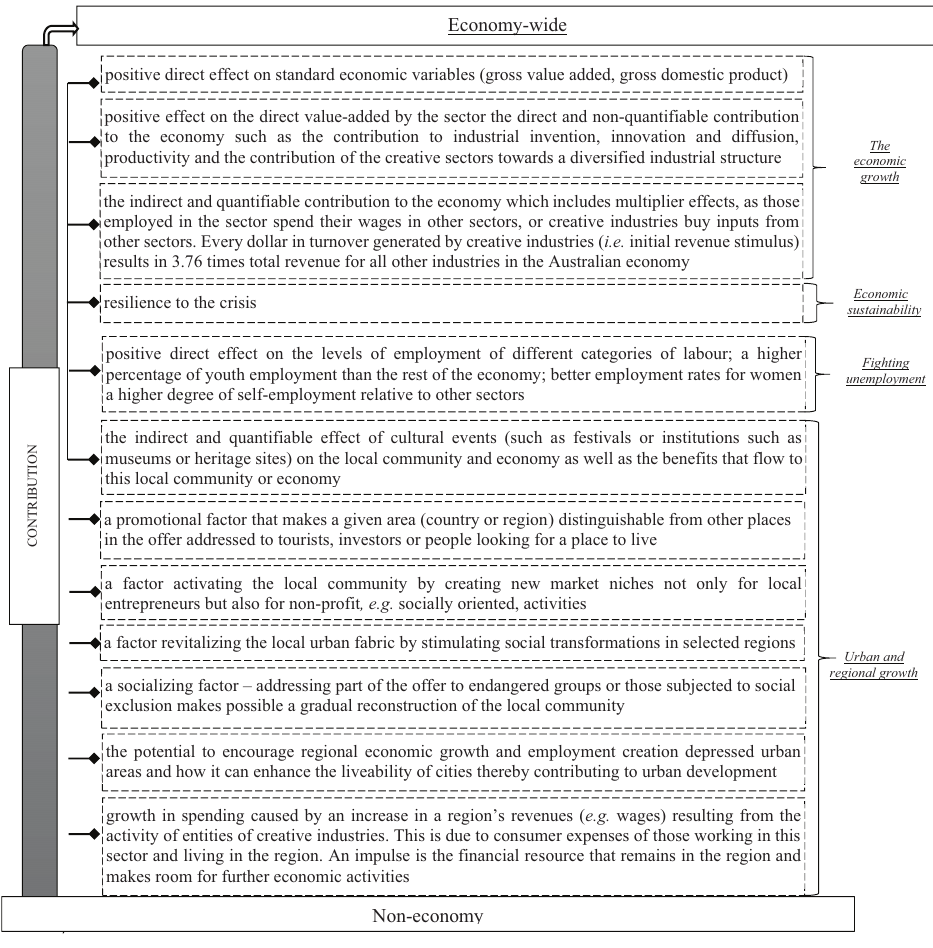
Figure 3. The benefits of creative industries (source: created by